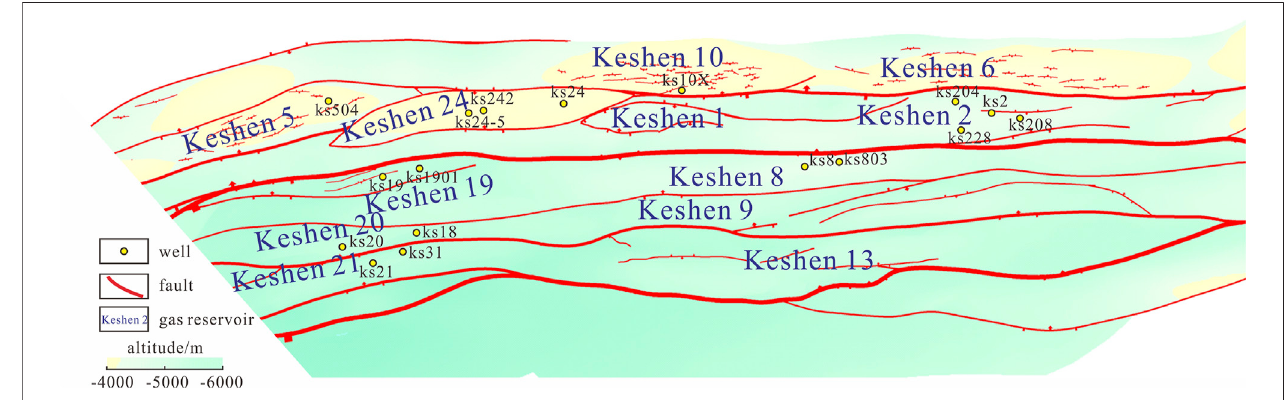
FIGURE 2 | Structure map of Cretaceous in Keshen gas fi